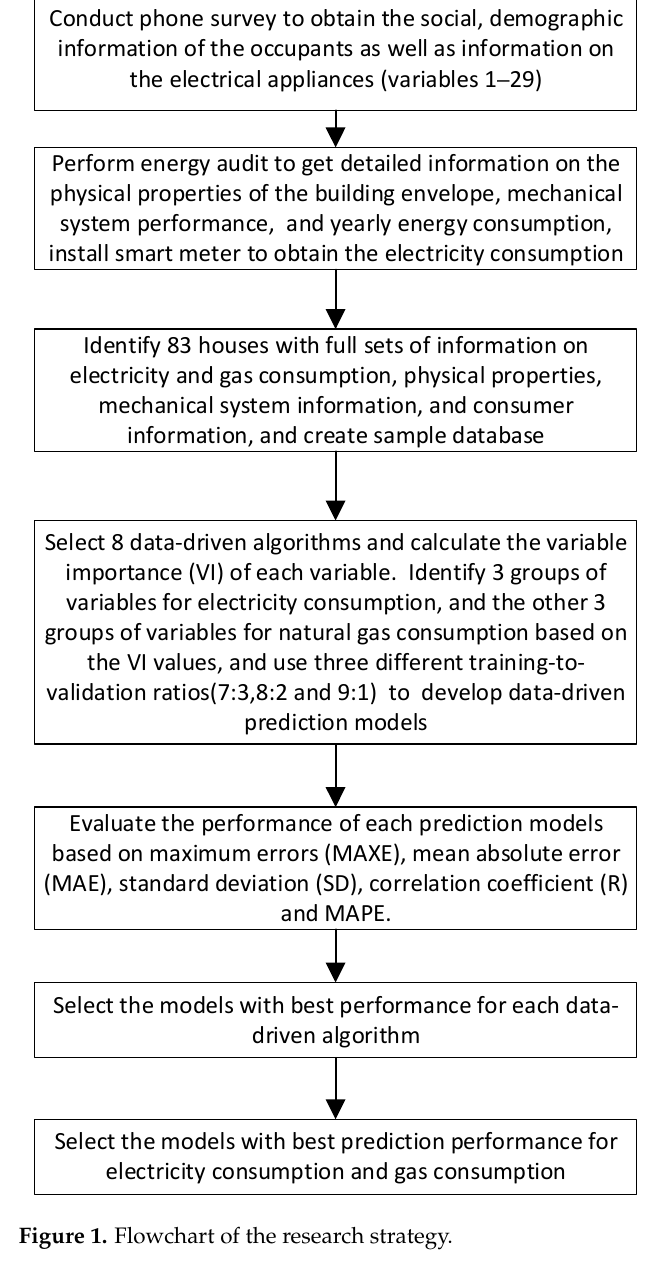
Table 1. Variable names and value ranges.